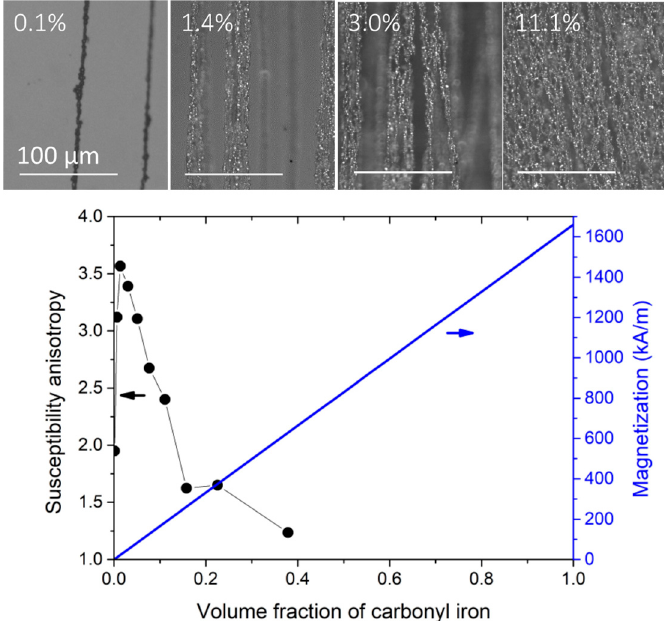
Figure 2. Anisotropic I-PDMS, prepared with an applied magnetic field of 130 mT. The top images are top views of I-PDMS membranes filled with volume concentrations of 0.1%, 1.4%, 3.0%, and 11.1% (from left to right). The columnar agglomerates are aligned in the direction of the applied magnetic field during the reticulation (vertical in the images). The graph shows the evolution of the anisotropy and the overall composite magnetization of the I-PDMS membranes. The susceptibility ratio is the ratio between the low field susceptibility in the direction of the applied field during the preparation and the in-plane perpendicular direction. Adapted with permission from [81] (http://creativecommons.org/licenses/by/4.0/).